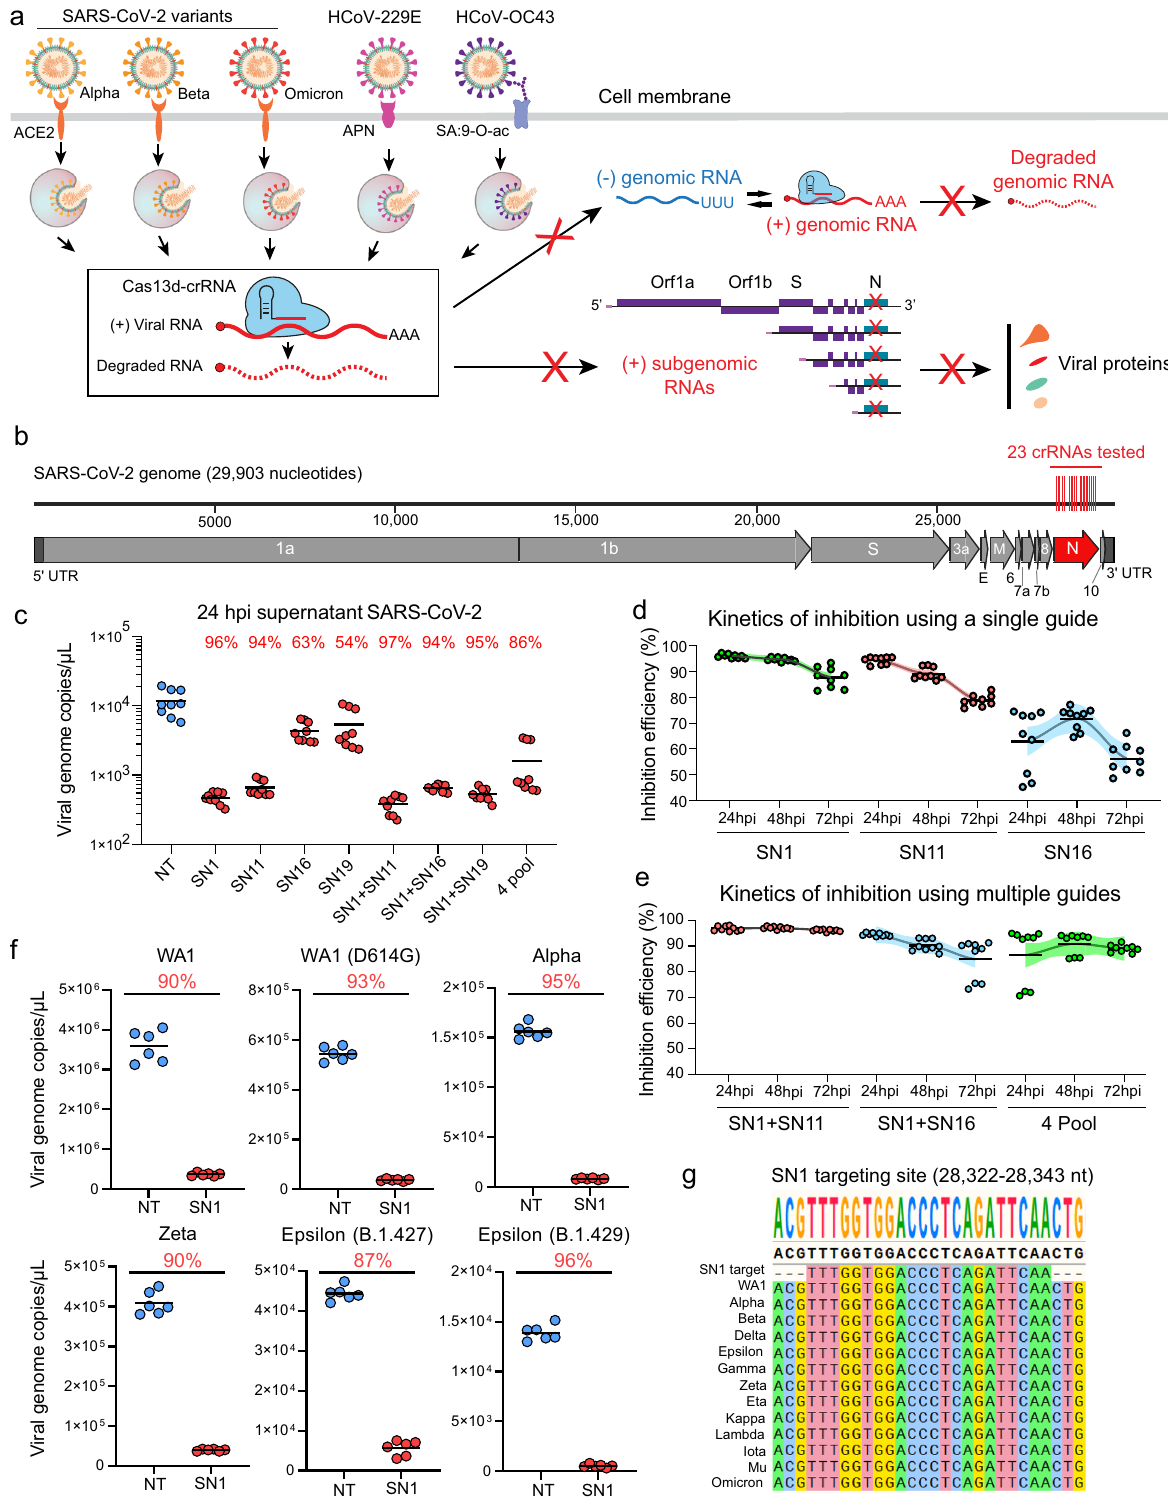
visibly protected from SARS-CoV-2-induced cytopathic effects (CPE), as assessed by cell morphology and density (Supplemen- tary Fig. 1e). The observed viral inhibition was highly dependent on the dosage of on-target crRNA lentivirus delivered to the Vero E6 cells, suggesting that cellular crRNA concentration is likely a limiting factor (Supplementary Fig. 1f). By measuring viral inhibition over time, we observed that while individual crRNAs NATURE COMMUNICATIONS| (2022) 13:2766